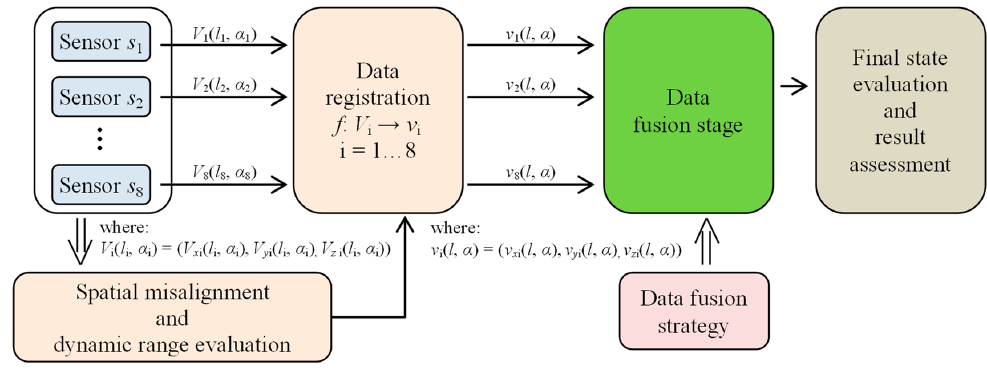
Figure 4. The general overview of the successive stages of the defect evaluation process.